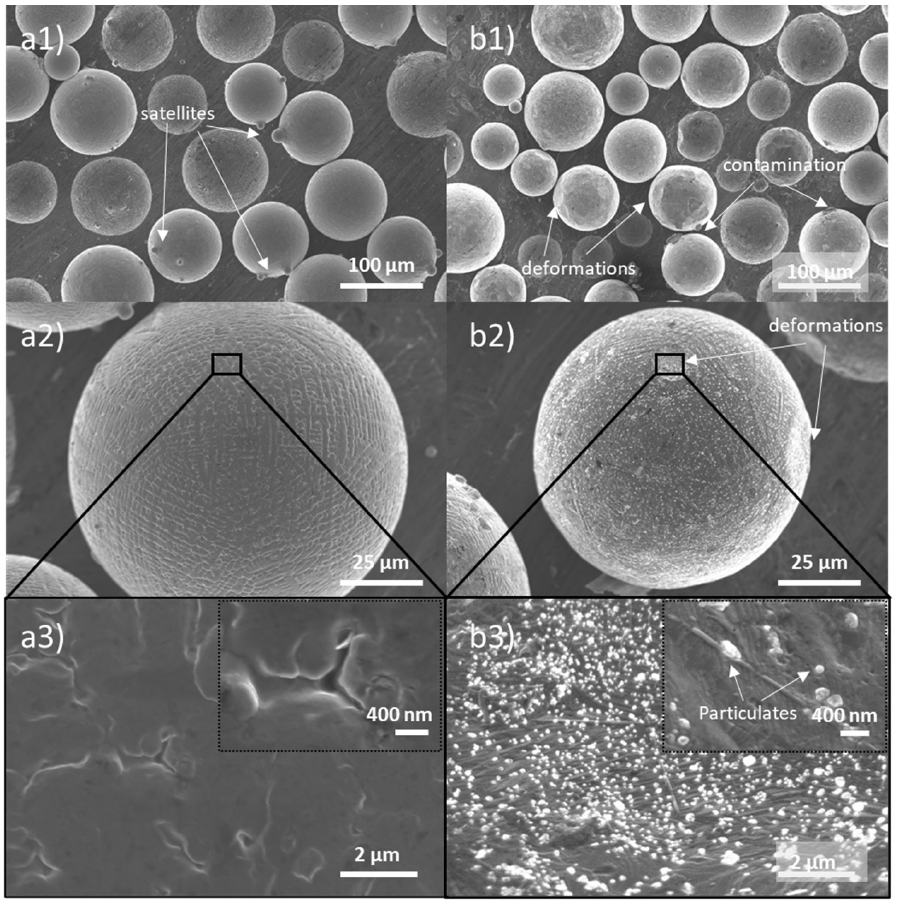
Figure 2. SEM micrographs of surface of virgin powder at 500, 2000 and magnifications, respectively, ( a1 – a3 ) and reused powder ( b1 – b3 ). Inserts in ( a3 , b3 ) at 100 K show presence of particulate oxide sizing up to 100 nm in case of reused powder and clean surface in case of virgin powder.